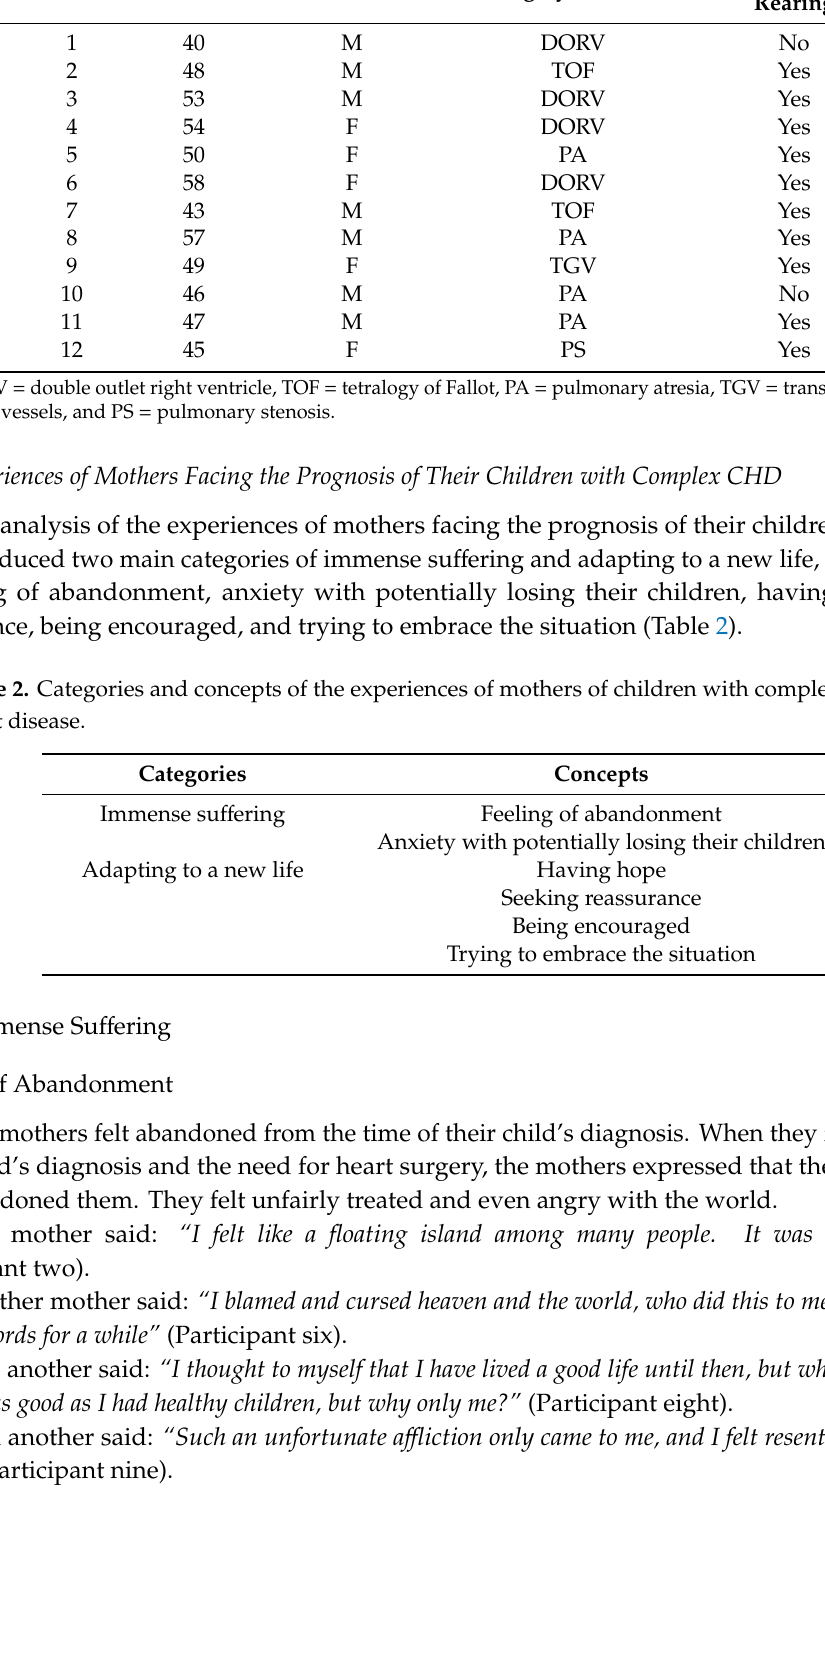
Husband’s Cause of the Support in Child Surgery of Child